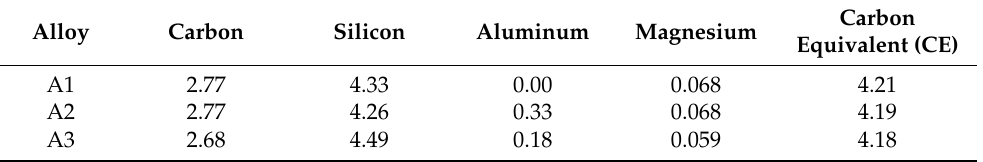
Table 1. Chemical composition of the three processed melts, contents in